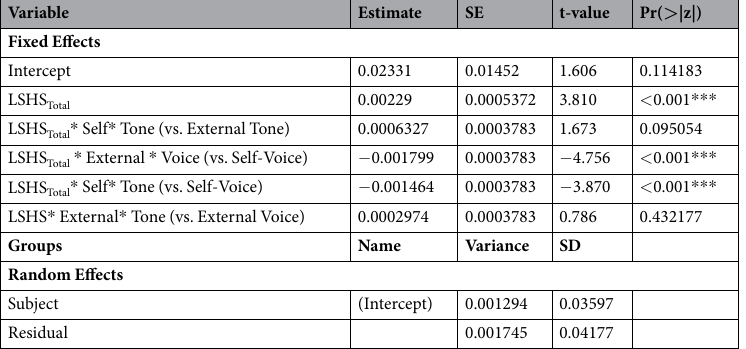
Table 2. Linear mixed effects model of pre-stimulus alpha power including the effect of hallucination predisposition. Notes . SE = standard error; SD = standard deviation; * p < 0.05; ** p < 0.01; *** p < 0.001. Degrees